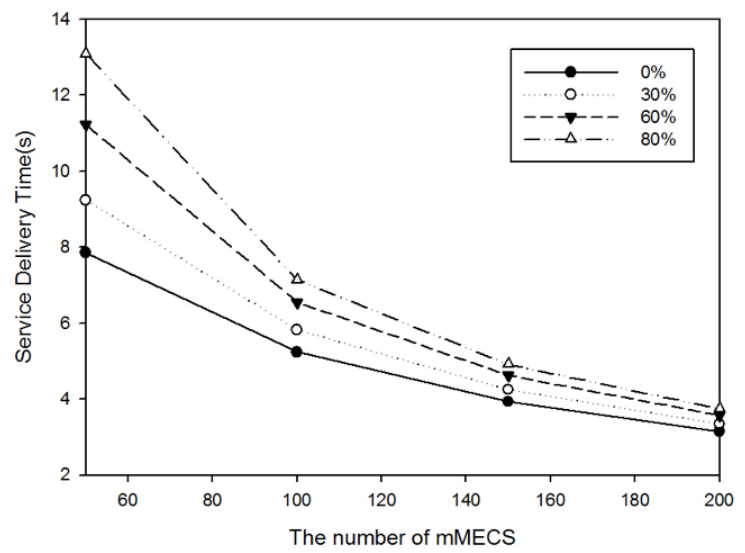
Figure 11. Service delivery time (Task sizes: